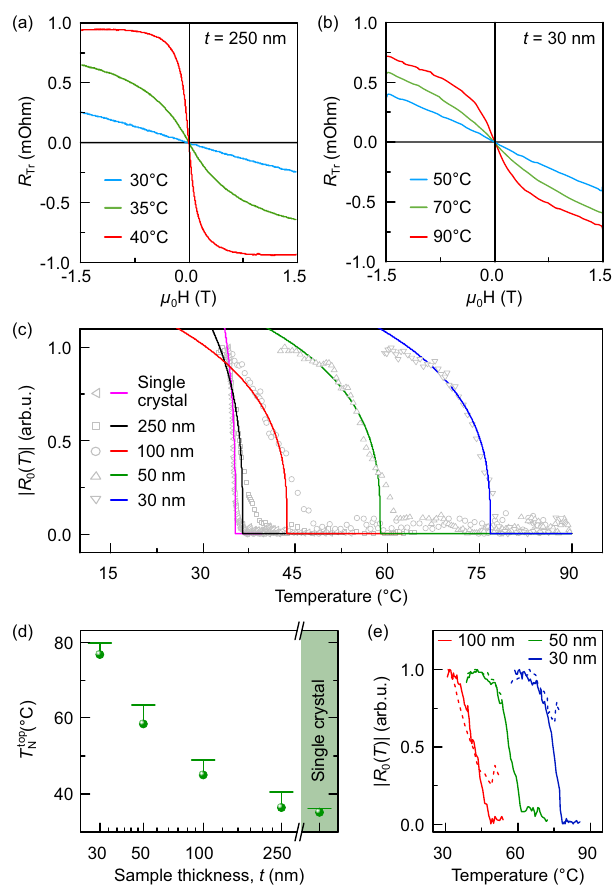
Fig. 2 | Assessment of the Néel temperature T top N at the top surface of Cr 2 O 3 fi lms. a , b Transverse resistance R Tr of the Pt electrode vs out-of-plane magnetic fi eld at temperatures below (blue), in the vicinity of (green) and above (red) the phasetransitiontotheparamagneticstateforthesamplesofdifferentthicknesses. c Temperature dependence of the antiferromagnetic contribution from the Cr 2 O 3 (Supplementary Note 5) isshown with symbols. The fi t used to determine the Néel temperature at the top surface of the sample is shown with solid lines. d Top sur- face Néel temperature T top N vs sample thickness. The Néel temperature measured on a single crystal is shown as well. Error bars arise from the smooth decay of the ∣ to the noise level in the vicinity of antiferromagnet-paramagnet transition. ∣ R 0 ( T ) e Temperature evolution of the antiferromagnetic contribution from the Cr 2 O 3